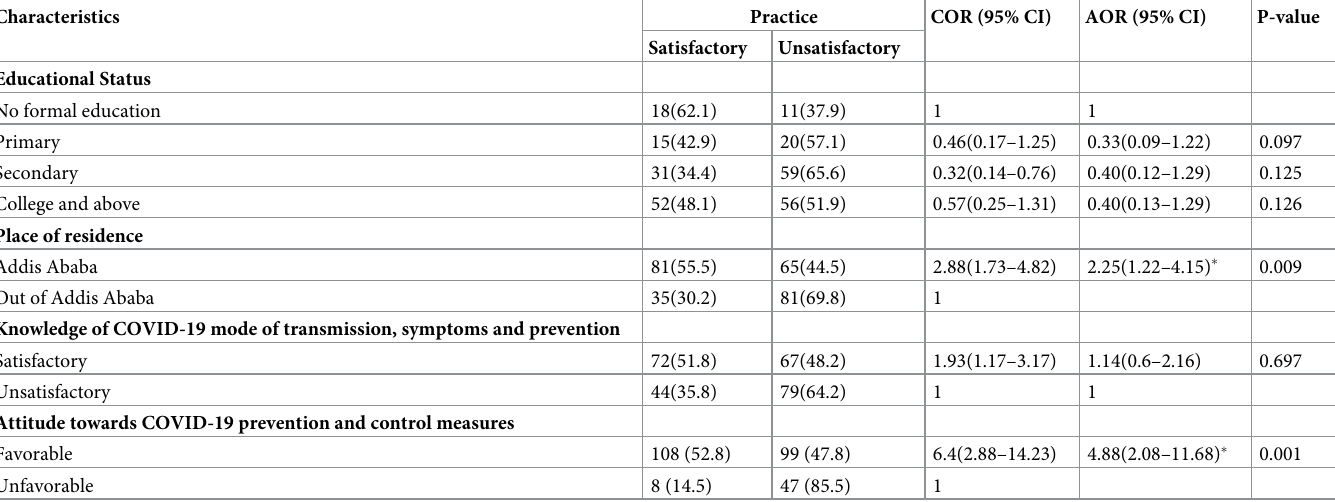
Table 6. Factors associated with COVID-19 precautionary practices in regression